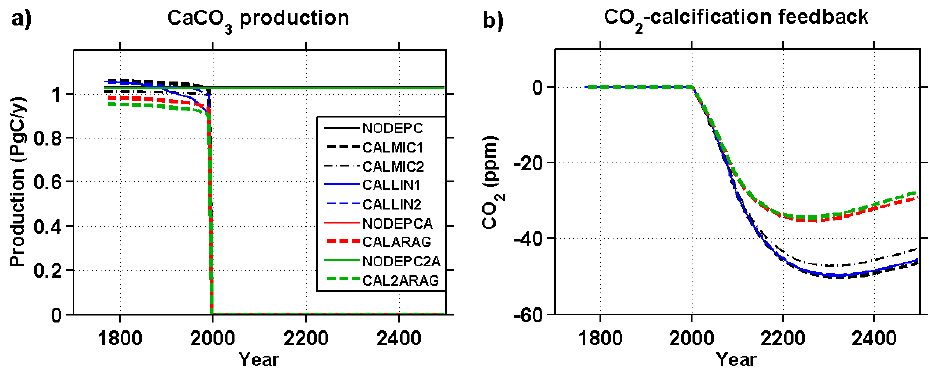
Fig. 15. Sensitivity of the different CaCO 3 production parameterizations to setting the global CaCO 3 production to 0 after the year 2000, as shown in (a) . Subfigure (b) illustrates the subsequent maximum potential value of the CO 2 -CaCO 3 production/dissolution